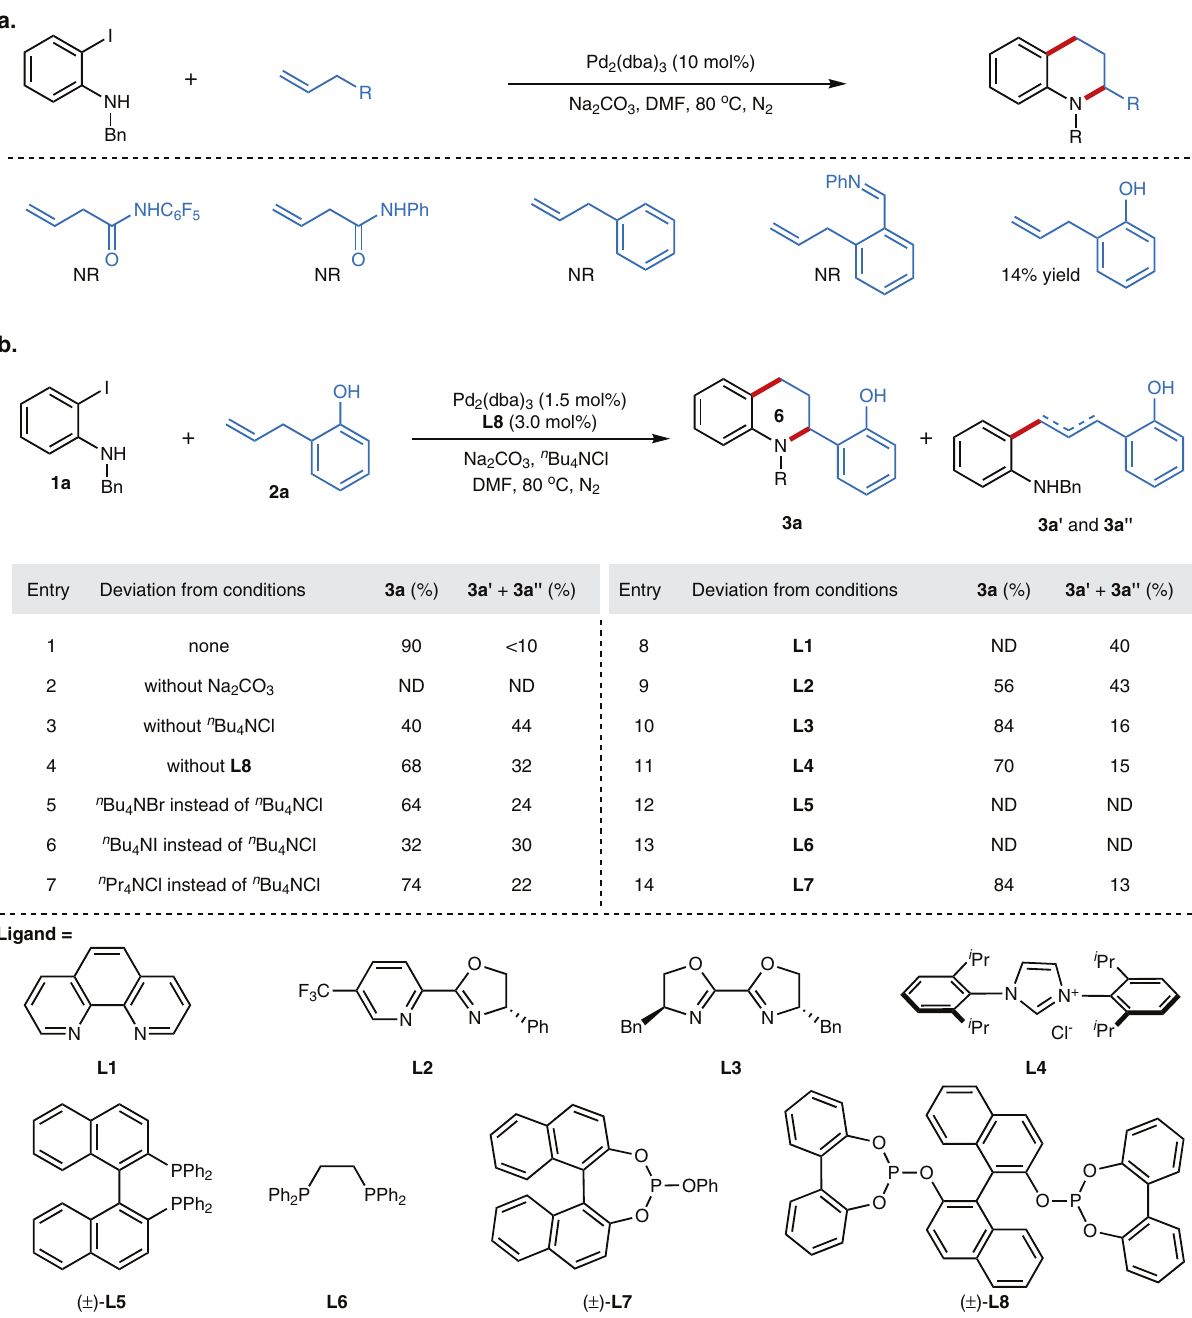
Fig. 2 | Reaction parameters evaluation for Pd-catalyzed migratory cycloan- nulation of unactivated alkenes. a Pd-catalyzed migratory cycloannulation of unactivated alkenes with different unactivated alkenes. b Reaction parameters evaluation. Bu, butyl; Bn, benzyl; Pr, propyl; Ph, phenyl; DMF,